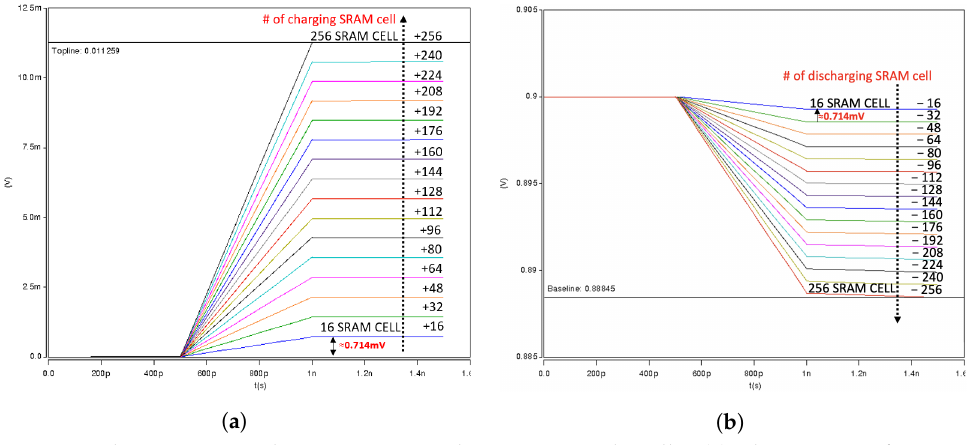
Figure 6. Charging or Discharging range with 256 × SRAM bitcells. ( a ) Charge range for up to +256 result. ( b ) Discharge range for up to − 256